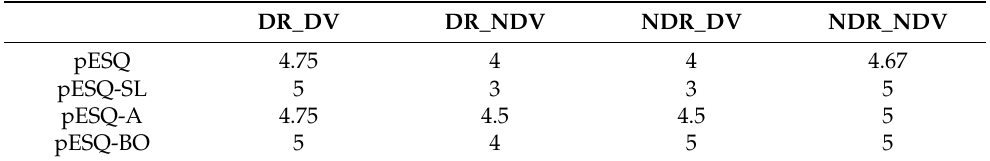
Table 1. Median pESQ values, including global score and subcomponents of embodiment: self- location (pESQ-SL), body ownership (pESQ-BO) and agency (pESQ-A).